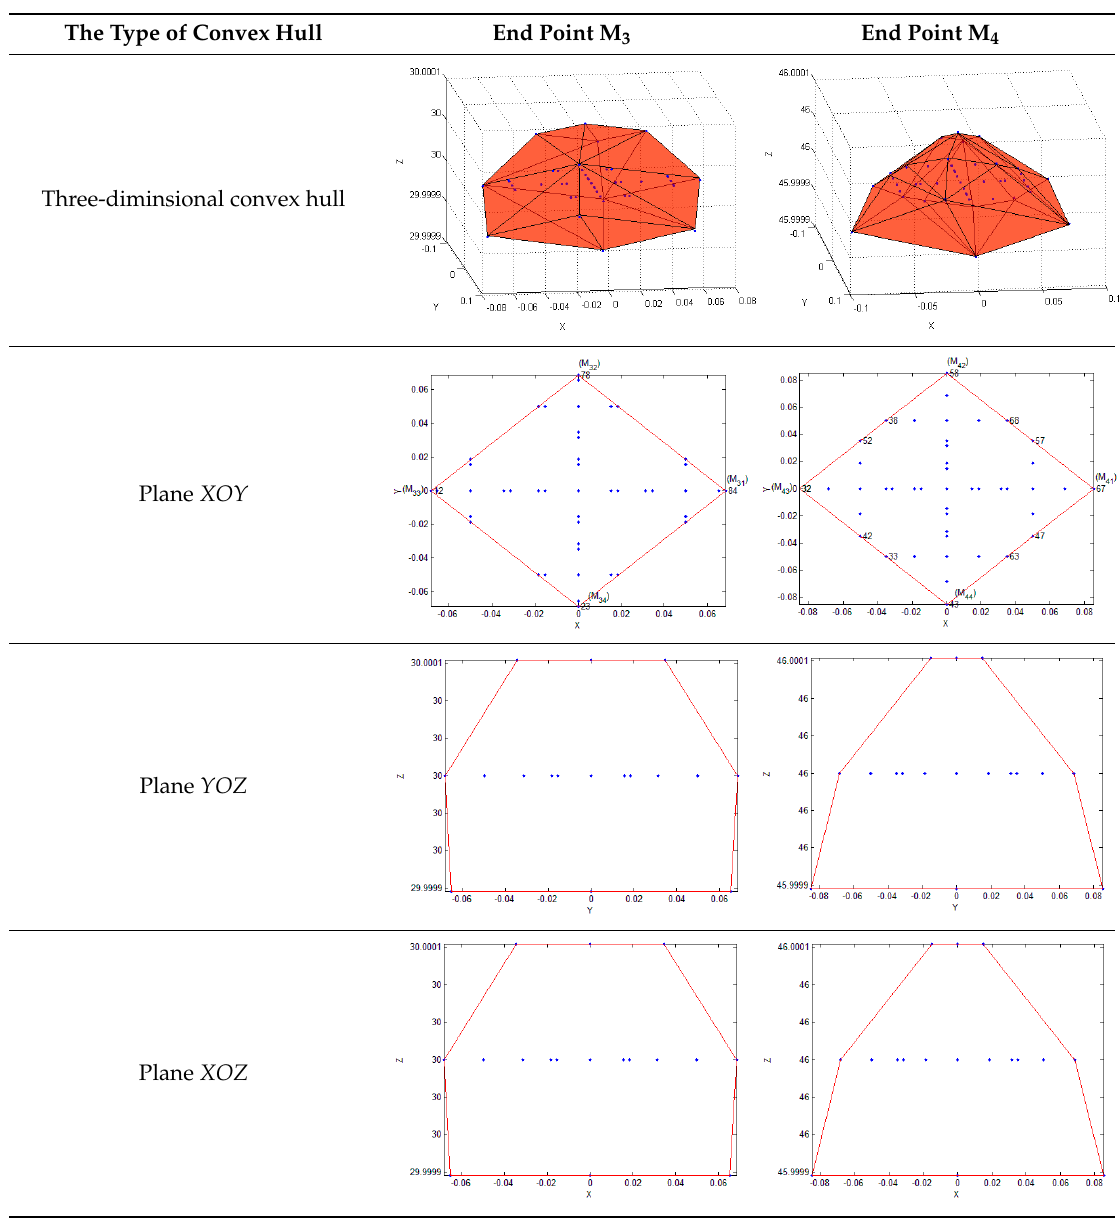
Table 2. Envelope diagram concerning variations of end point M 3 and M 4 of shaft and gear axis.